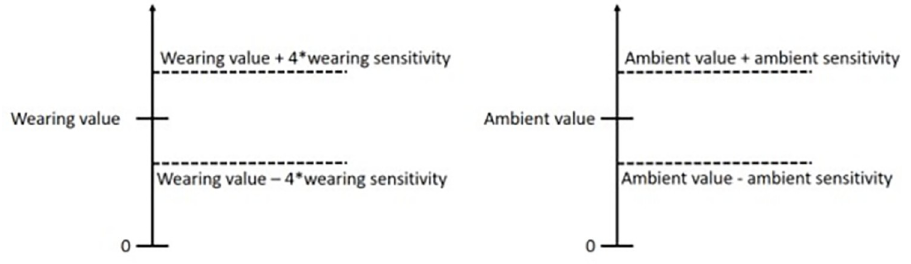
Fig 2. Interaction of sensitivity values with the calibration values for wearing position detection.